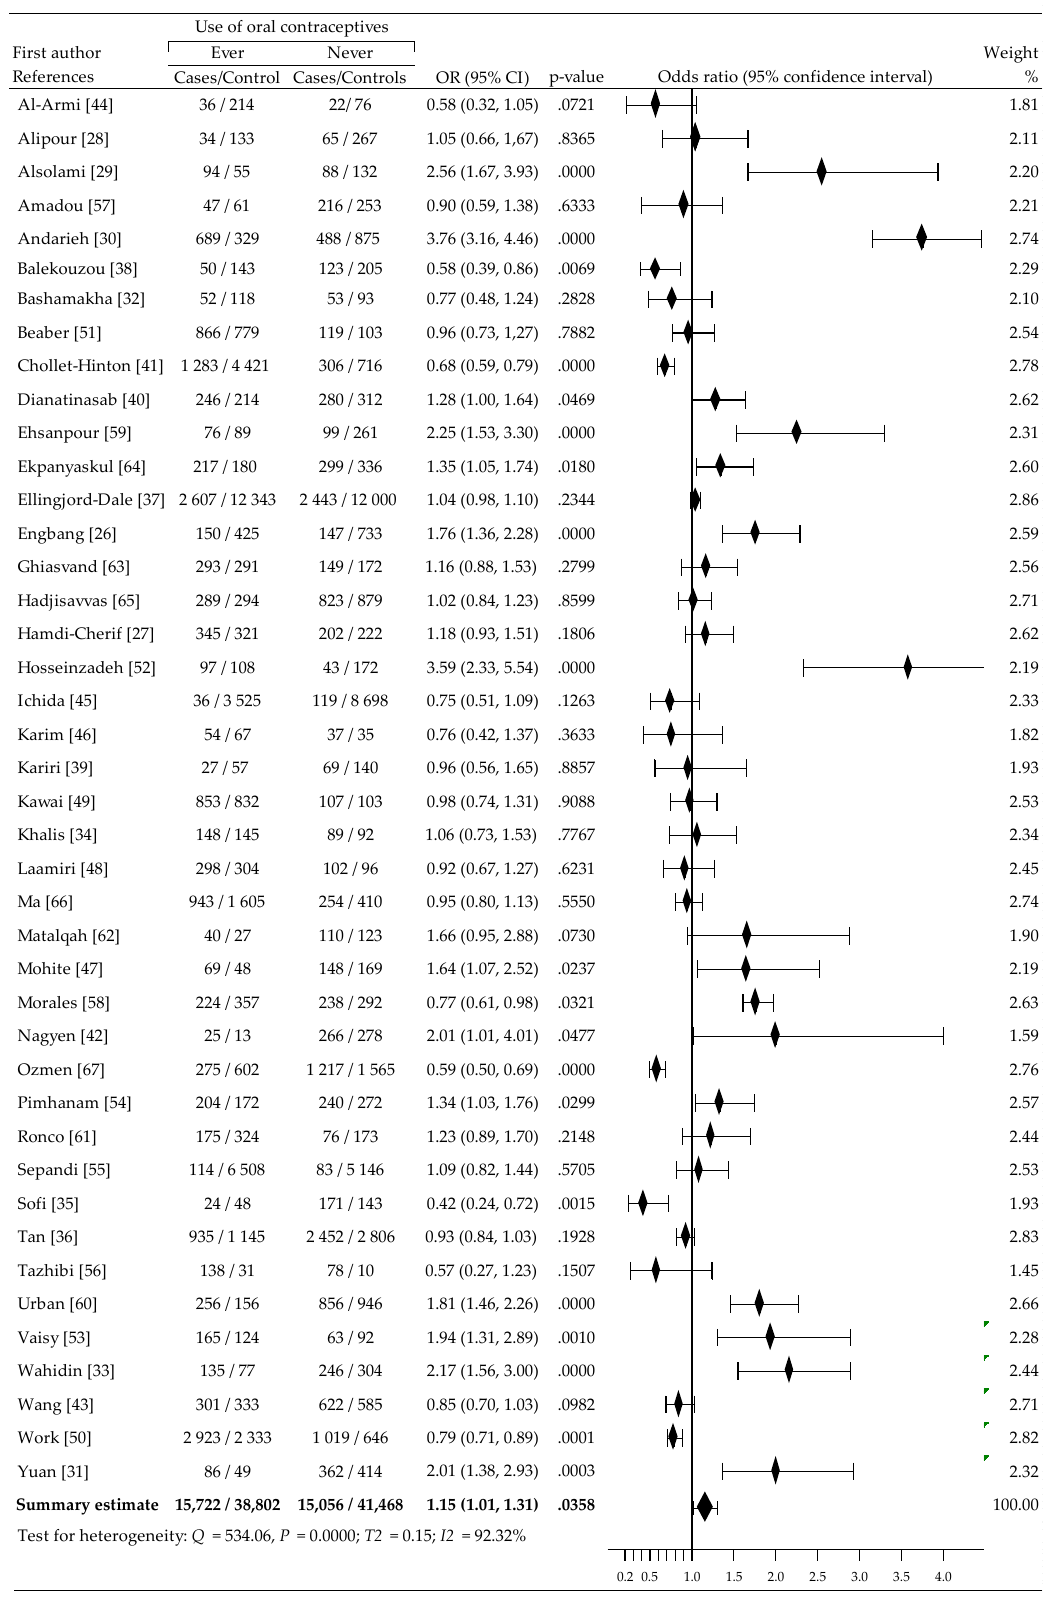
Figure 2. A forest plot and the summary odds ratios for the relationship between BrCa risk and ever OC use: case-control studies conducted 2009–2020 in alphabetical